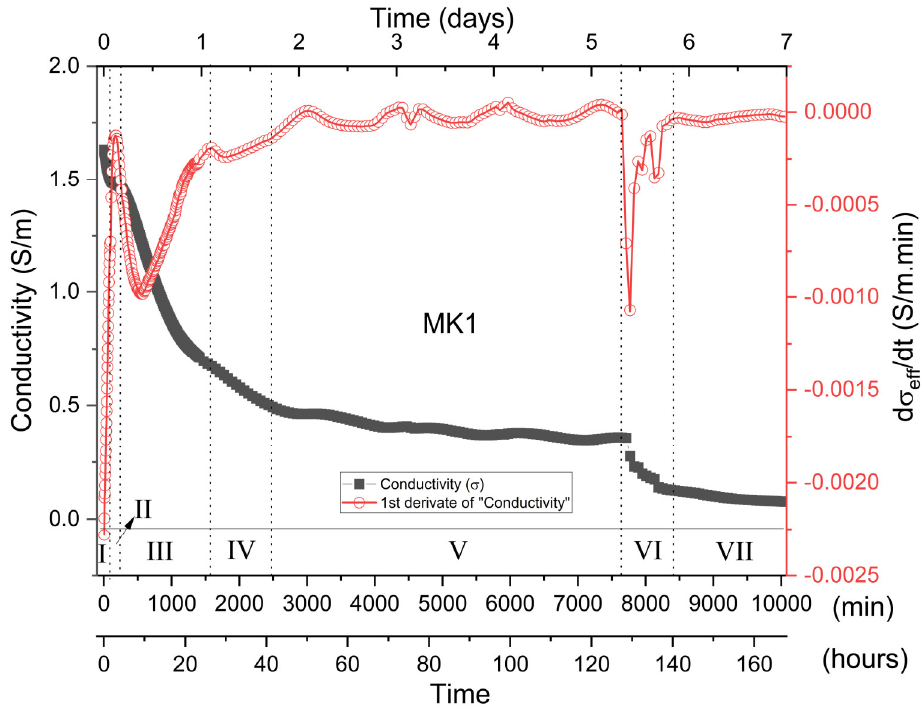
Figure 6. Effective electrical conductivity, σ eff , and its derivative, d σ eff /dt, as a function of the time reaction for MK1-based geopolymer. Highlighted regions of I–VII.